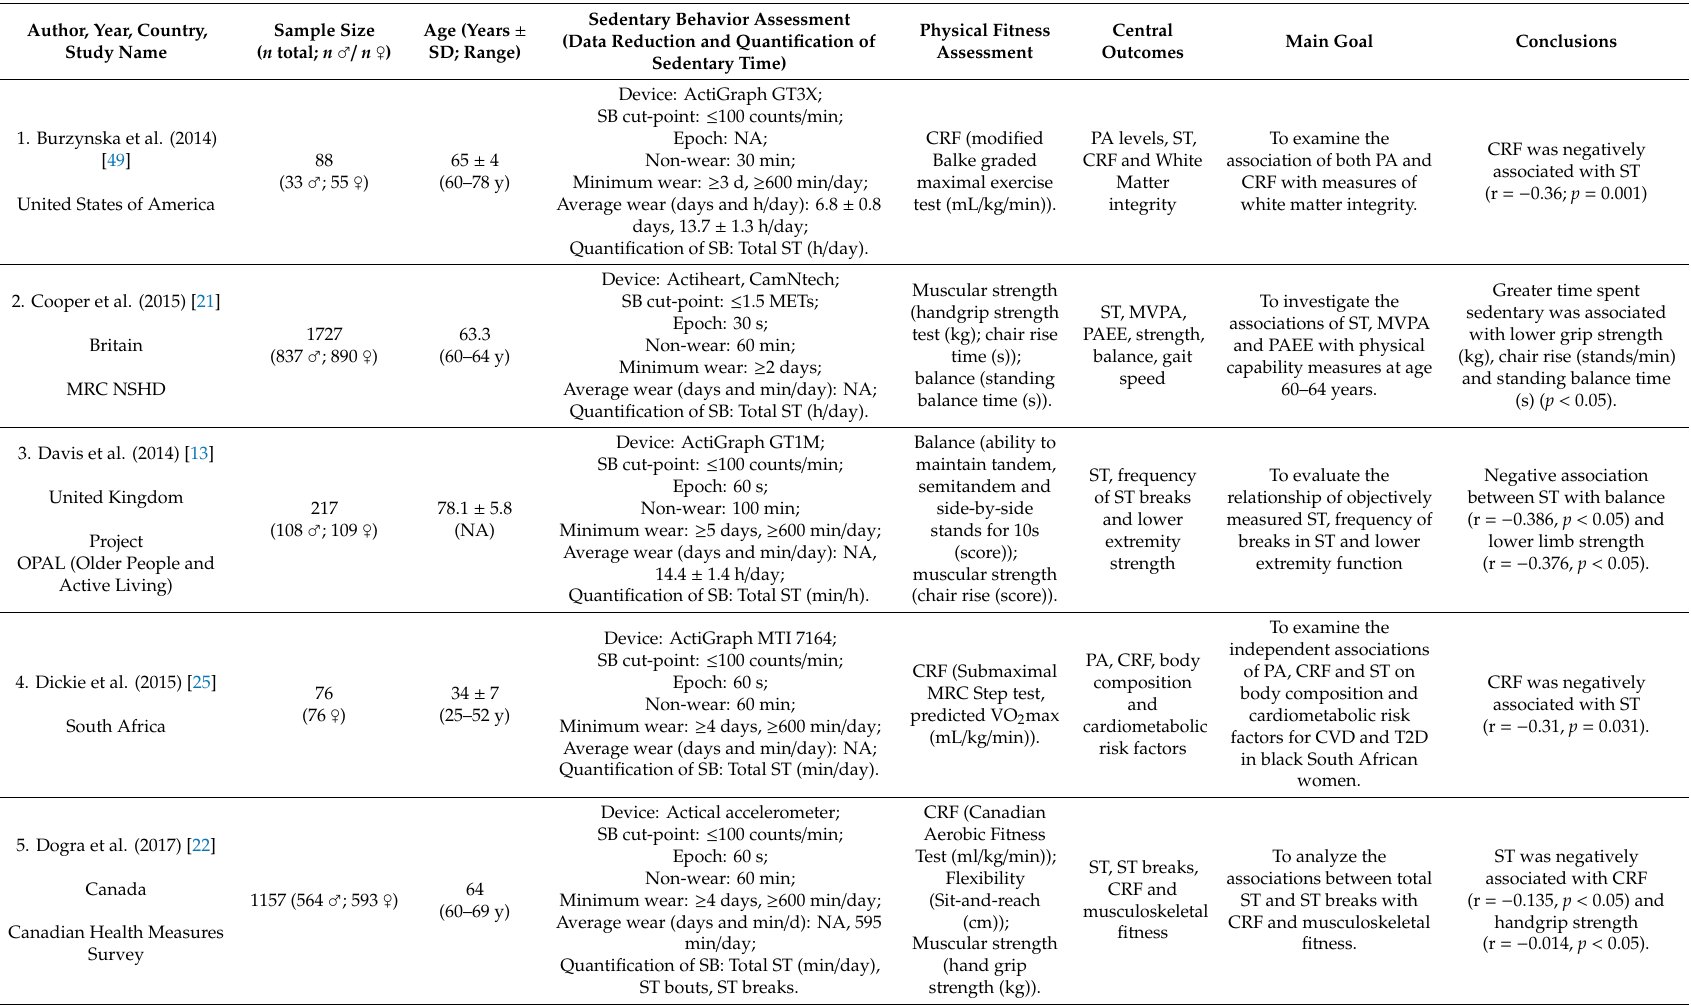
Table 2. Characteristics of the 21 selected studies for systematic review and